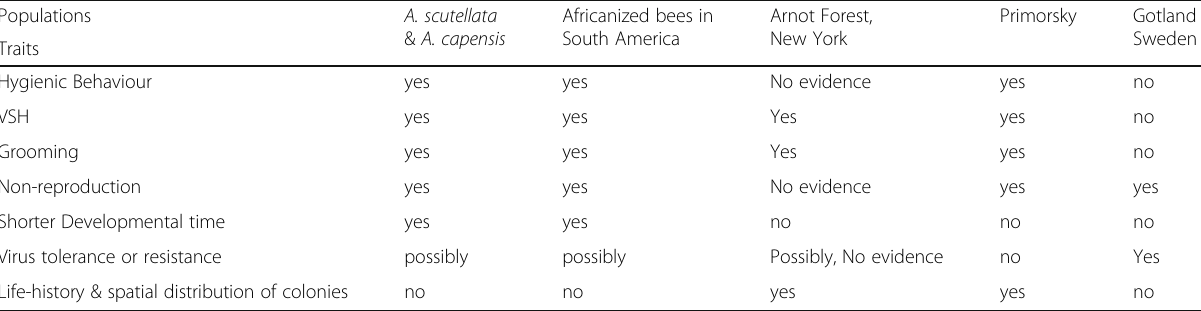
Table 1 Traits that have been measured and/or invoked to explain resistance